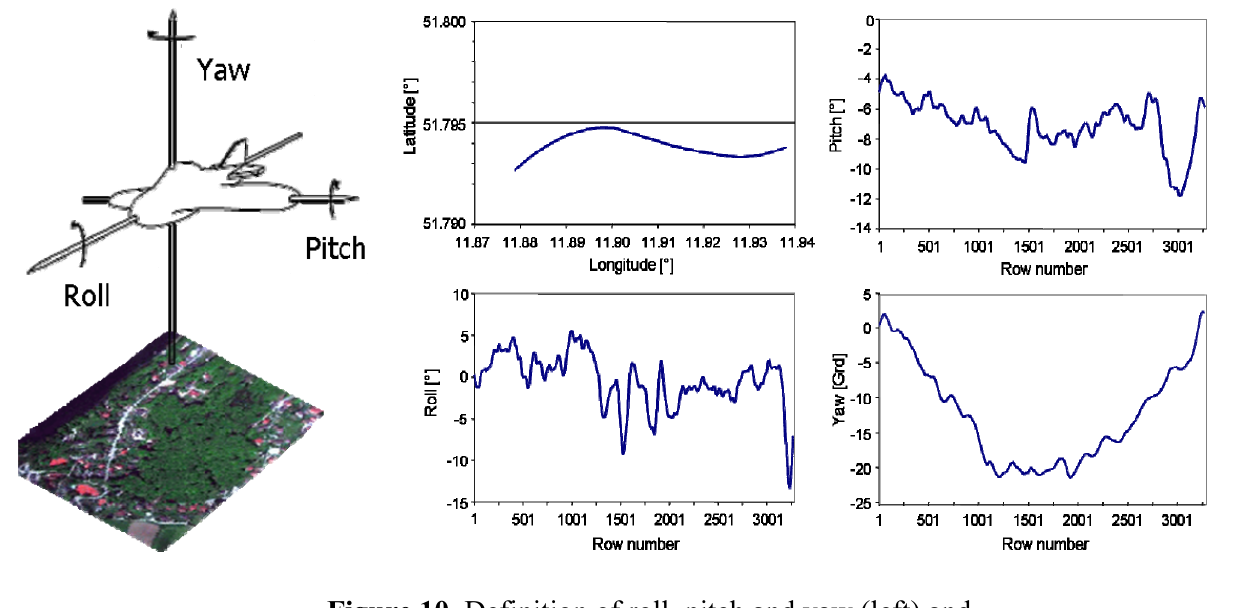
Figure 10. Definition of roll, pitch and yaw (left) and dGPS/INS recordings during a flight line